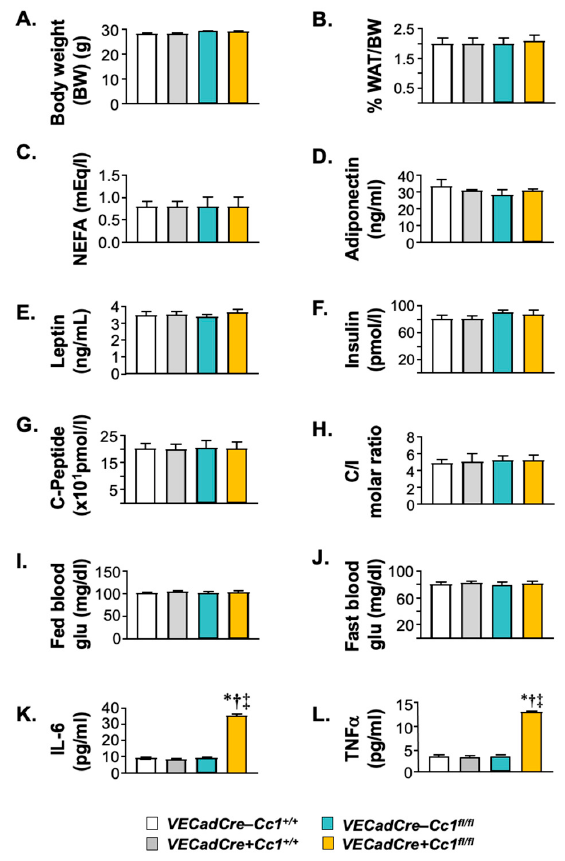
Figure 2. Biochemistry of plasma and tissues. Male mice (8 months of age, n ≥ 5/genotype) were fasted overnight from 5:00 p.m. until 11:00 a.m. the next morning before retro-orbital blood was drawn and tissues were excised. ( A ) body weight (BW). ( B ) % WAT/BW visceral adiposity measured as percentage of BW. Plasma levels of ( C ) non-esterified fatty acids (NEFA), ( D ) adiponectin, ( E ) leptin, ( F ) insulin, ( G ) C-peptide, ( K ) interleukin-6 (IL-6) and ( L ) tumor necrosis factor α (TNF α ) were determined. ( H ) steady-state plasma C-peptide/insulin molar ratio (C/I) was calculated as measure of insulin clearance. Blood glucose (Glu) levels were determined at about 3–4 h of the beginning of the dark cycle (fed) ( I ) and fasting ( J ) states were also assessed. Values are expressed as mean ± SEM. * p < 0.05 vs. VECadCre-Cc1 +/+ , † p < 0.05 vs. VECadCre+Cc1 +/+ , ‡ p < 0.05 vs. VECadCre-Cc1 fl/fl